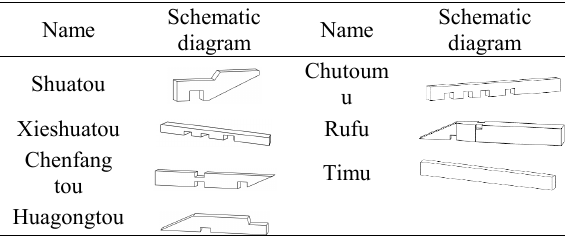
Table 2. Typical components in three types of